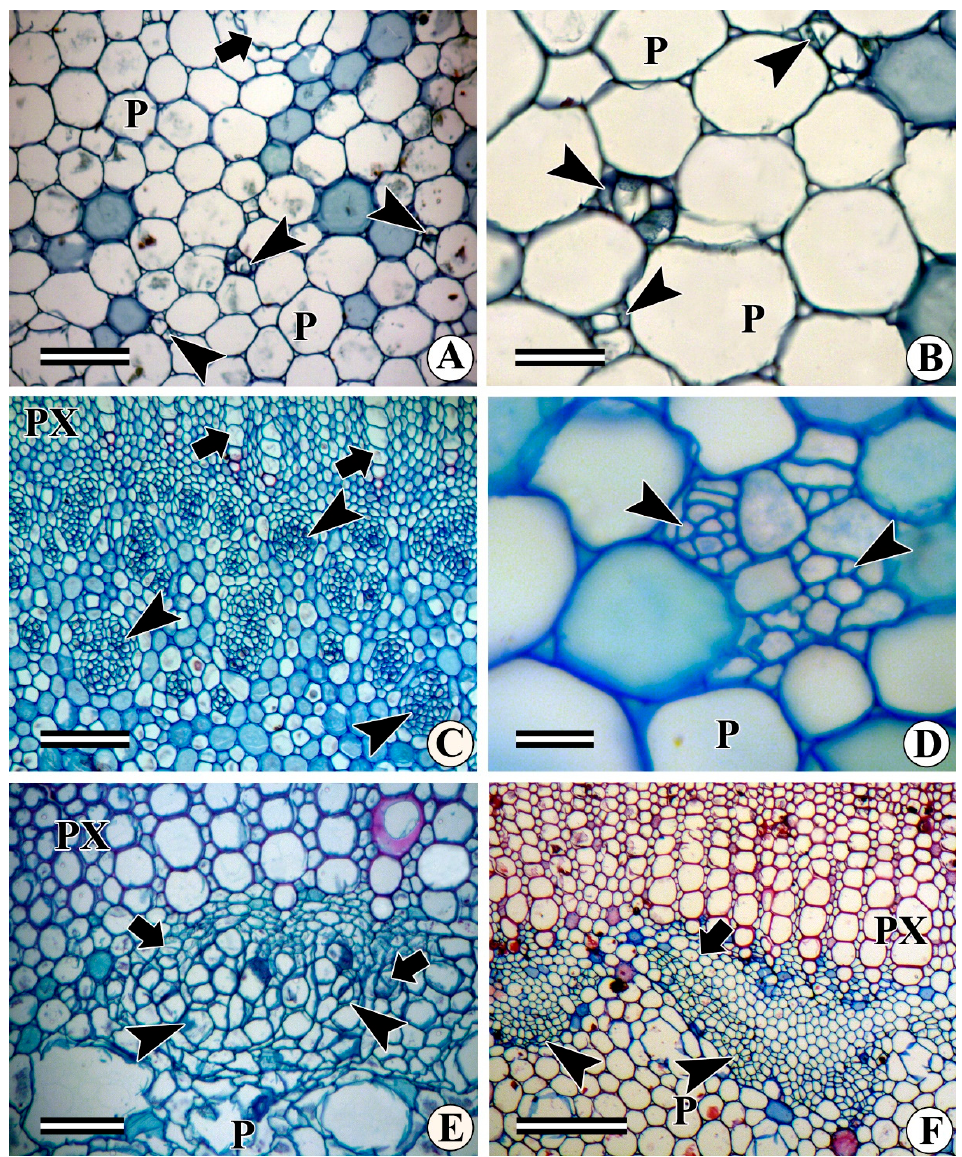
Figure 9. Transverse view of the pith portion of the stems showing intraxylary phloem distribution. ( A,B ) Isolated strands of intraxylary phloem (arrowheads) in the pith portion ( A ) and enlarged view ( B ) of Argyreia sericea . Arrow indicates laticifers. ( C ) Distribution of intraxylary phloem (arrowheads) in the pith of Beaumontia jerdomiana . Arrows show protoxylem. ( D ) Enlarged view of Figure 8E showing the morphology of sieve elements (arrowheads). ( E,F ) Intraxylary (secondary) phloem showing clusters of the sieve elements (arrowheads). Note the dividing peri-medullary cells (arrows) in Merremia hederacea ( E ) and A. osyrensis ( F ). Abbreviations : P = pith cells, PX = protoxylem. Scale bars: A, C, E = 100 m; B = 50 µm, D = 20 µm, F = 200 µm.